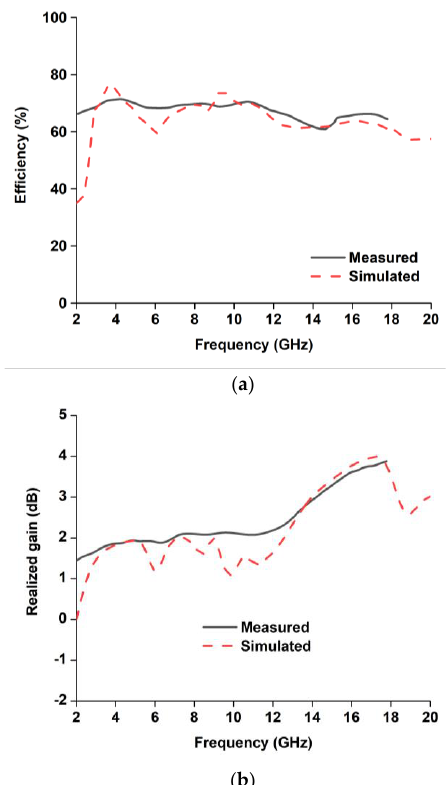
Figure 11. Simulated and measured ( a ) efficiency and ( b ) gain of the UWB antenna. For dispersion analysis in the time domain, the antenna is derived by the input signal. The transmitted and received signal without and with HSRR is illustrated in Figure 12. From the pulse